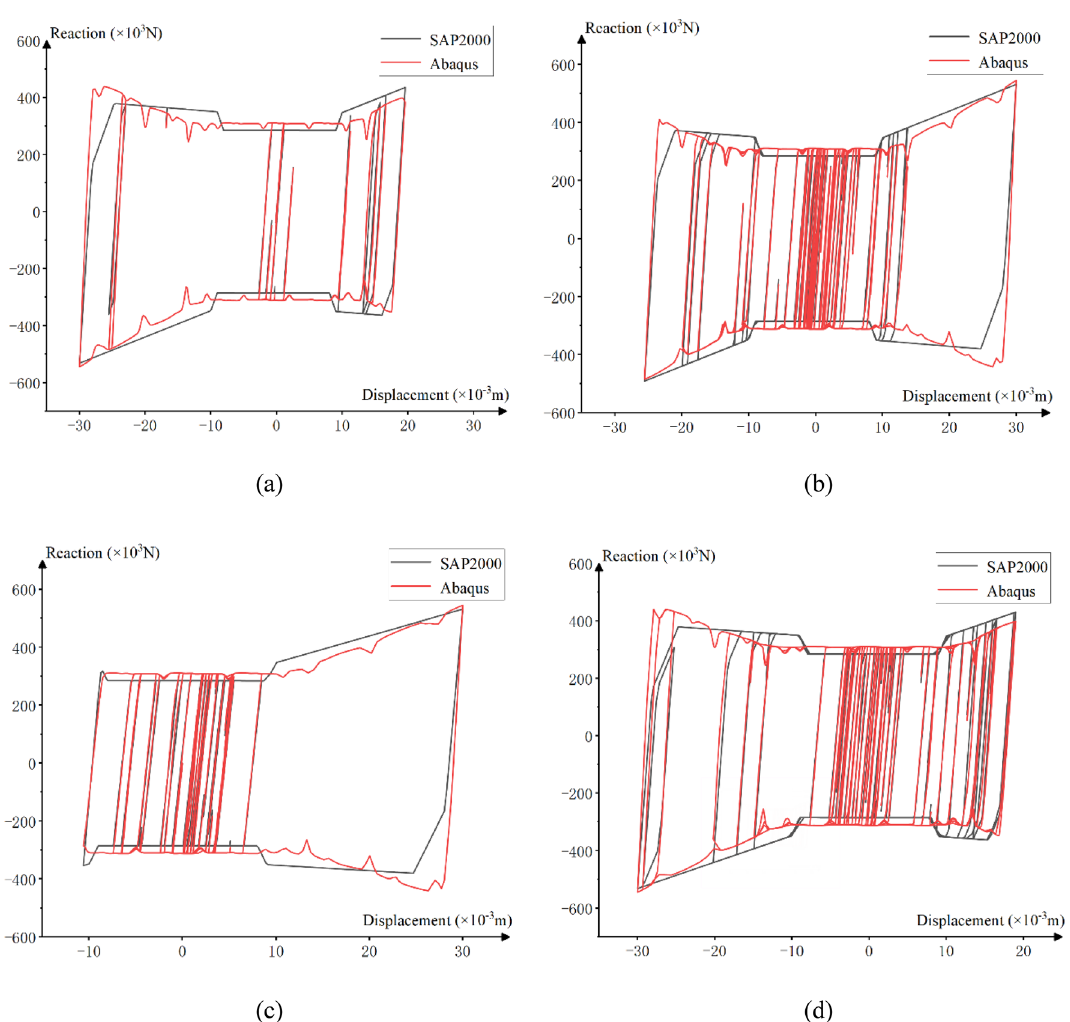
Fig. 19 Comparison of Response time history yielded from SAP2000 SDoF and Abaqus solid FEA